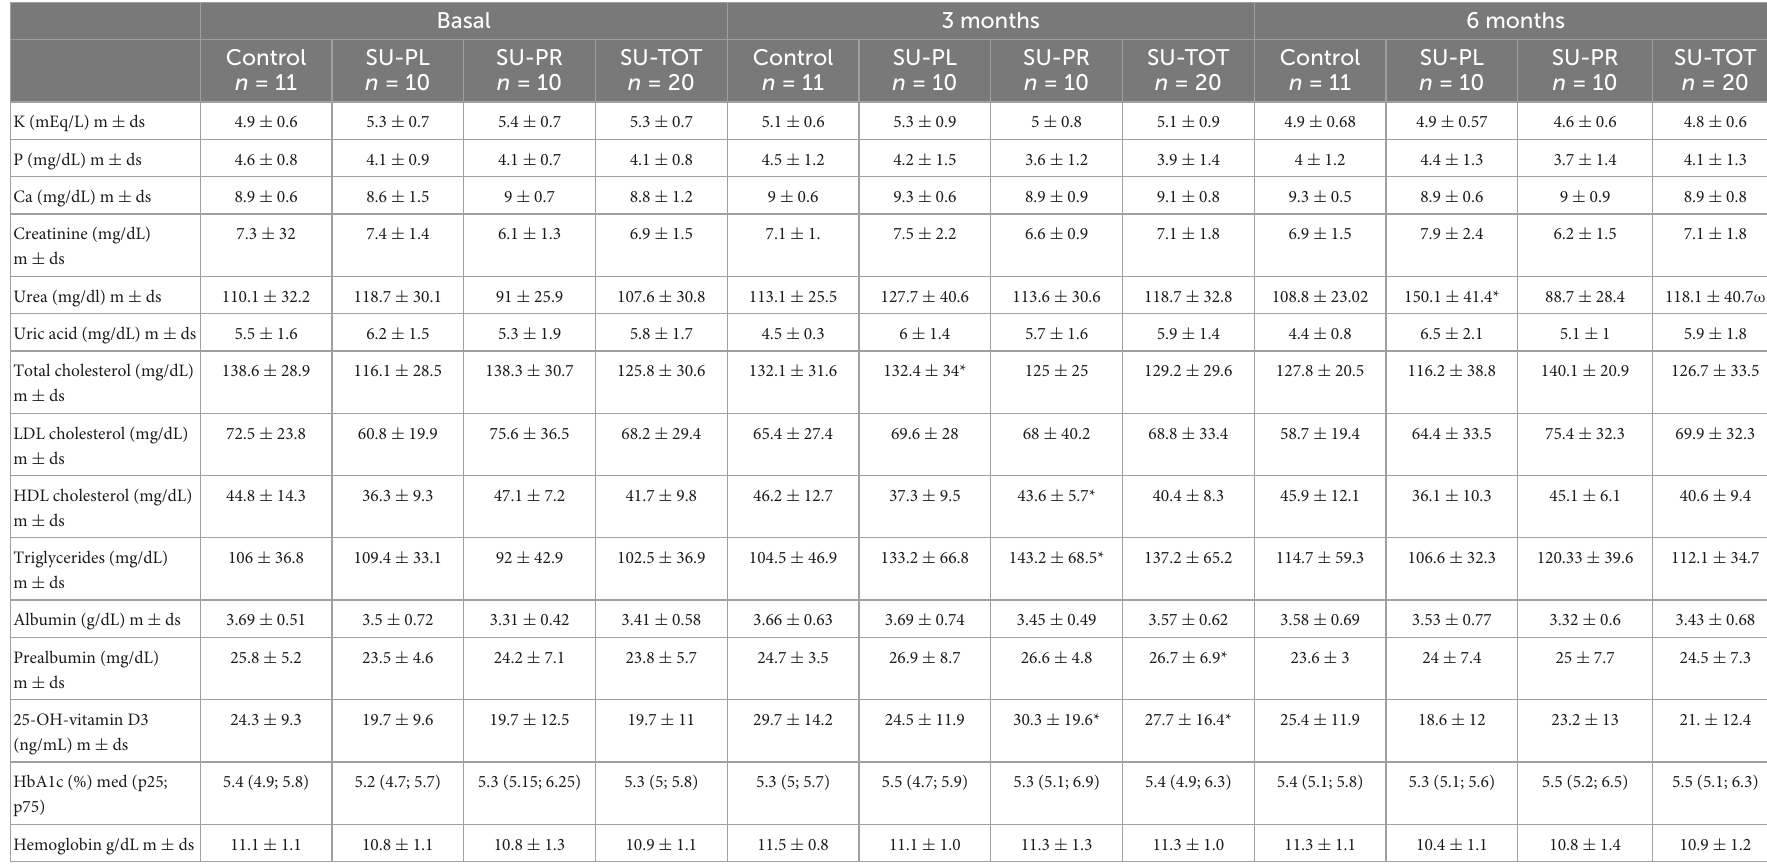
TABLE 5 Blood test